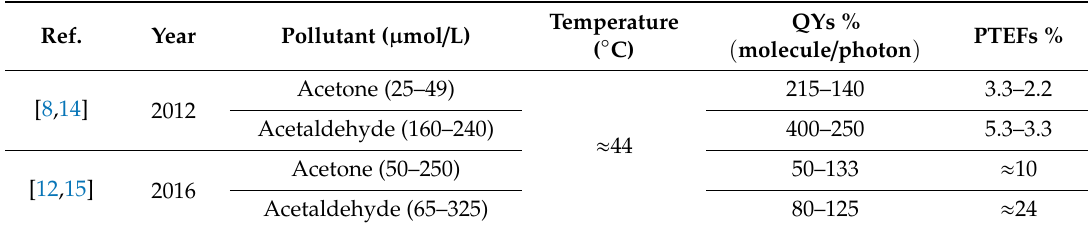
Note: the numbers in parentheses () are the pollutant concentration represented in μ mol/L.